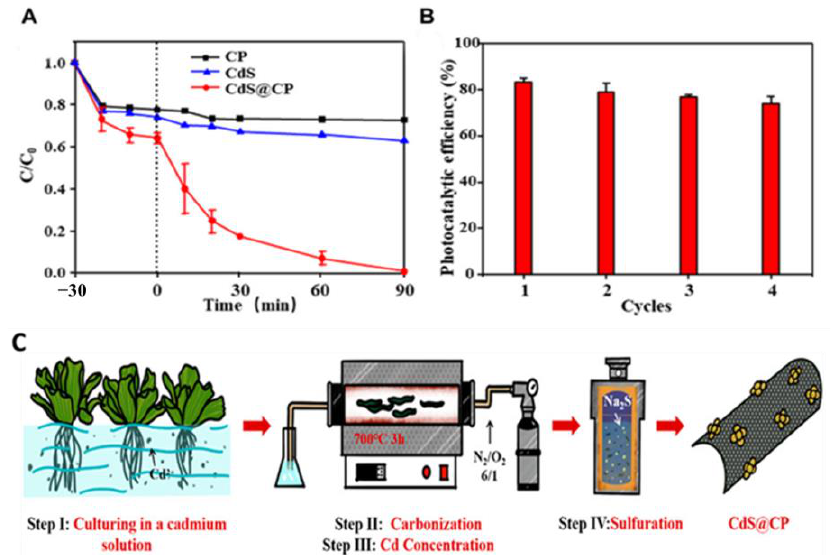
Figure 21. ( A ) RhB degradation efficiency of CP (Pistia stratiotes-derived biochar), CdS, and CdS@CP; ( B ) recycling reactions when using CdS@CP; ( C ) schematic illustration of the procedures for CdS@CP photocatalyst composites. Adapted with permission from ref. [122].